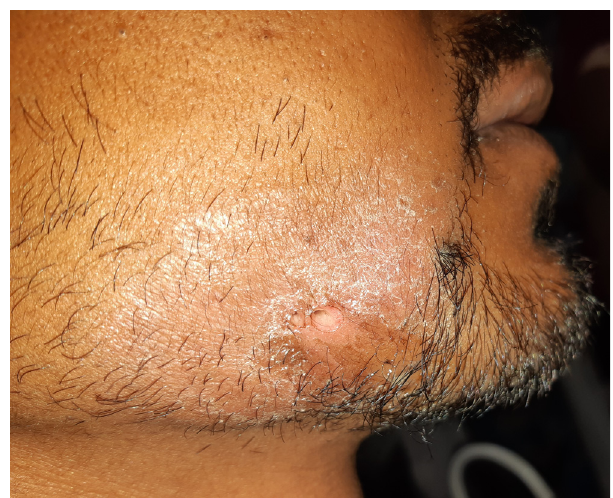
Fig. 1. Image showing swelling and draining sinuses in the right mandibular body region.